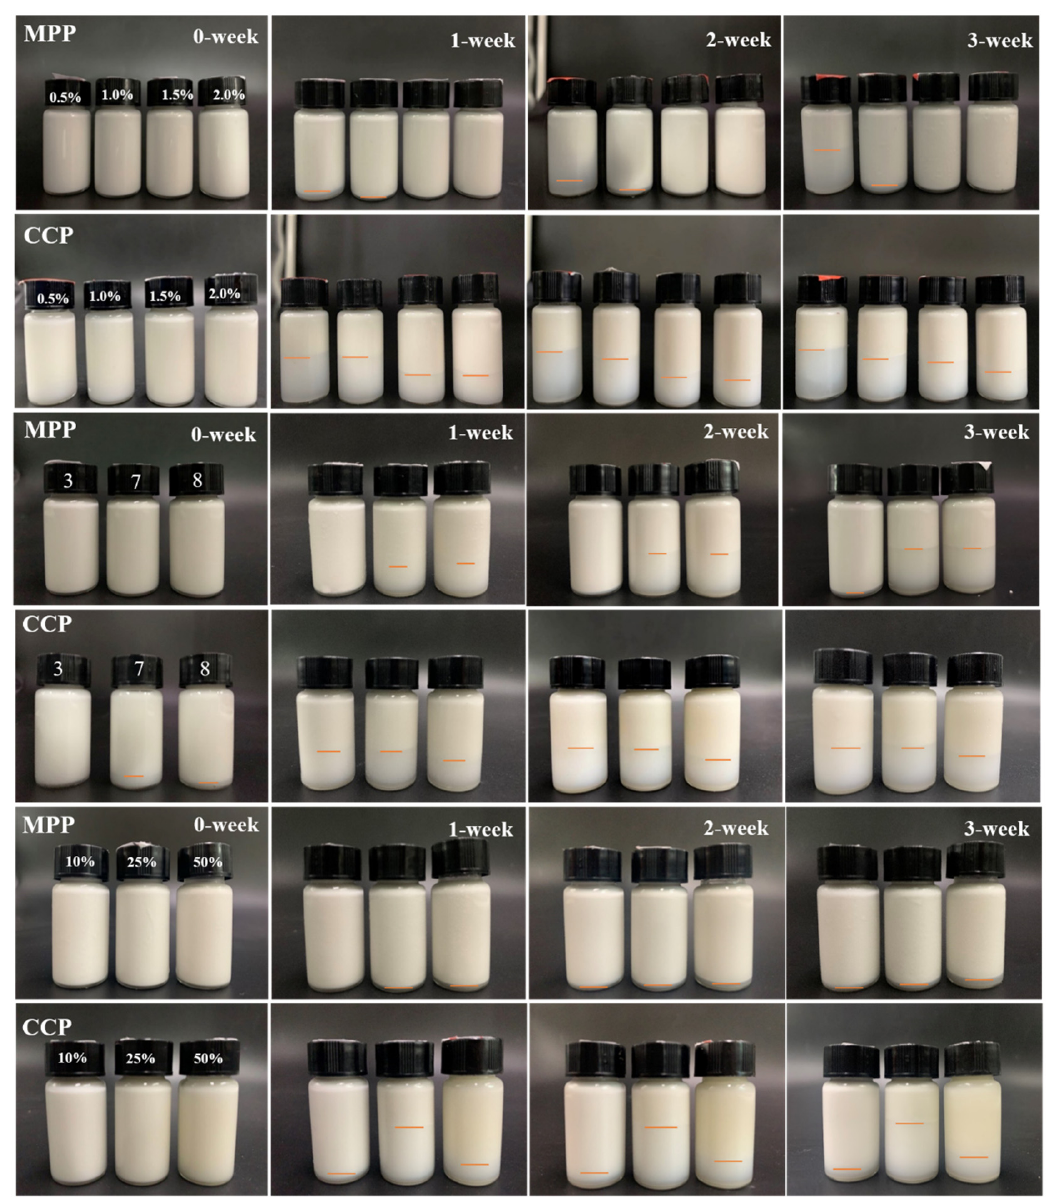
Figure 4. Macroscopic pictures of emulsions prepared by MPP and CCP over 3-week storage. A scanning light-scattering instrument was used to test the physical stability of the emulsion. Moreover, centrifugal determination and storage evaluation, assisted by the macro photos during the storage process, comprehensively evaluated the emulsion stability. Table 7. Centrifugation and storage stability of MPP and CCP emulsions prepared by different conditions.